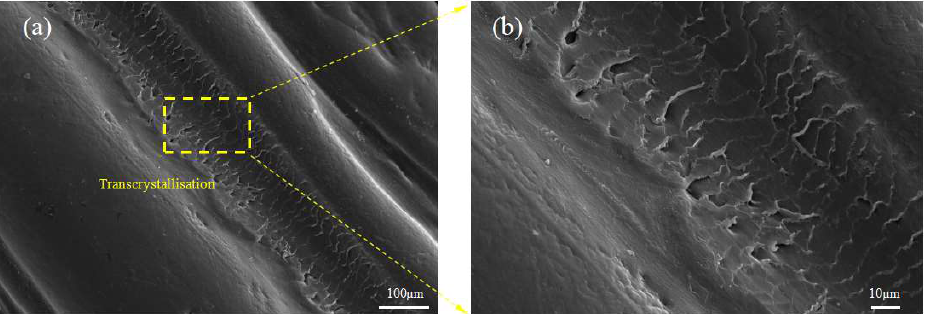
Figure 11. SEM image of a longitudinal section etched by potassium treatment of CFSRCs. ( a ) SEM image of transcrystallization in CFSRCs. ( b ) Details of transcrystallization in CFSRCs.